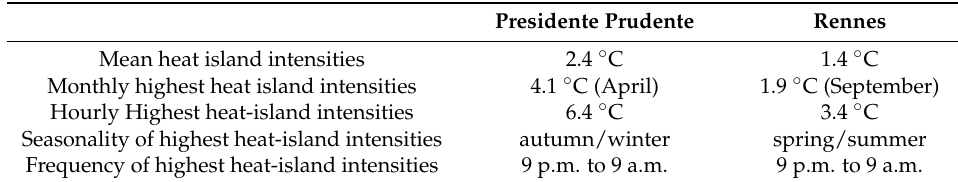
Table 4. Characteristics of heat islands in Presidente Prudente and